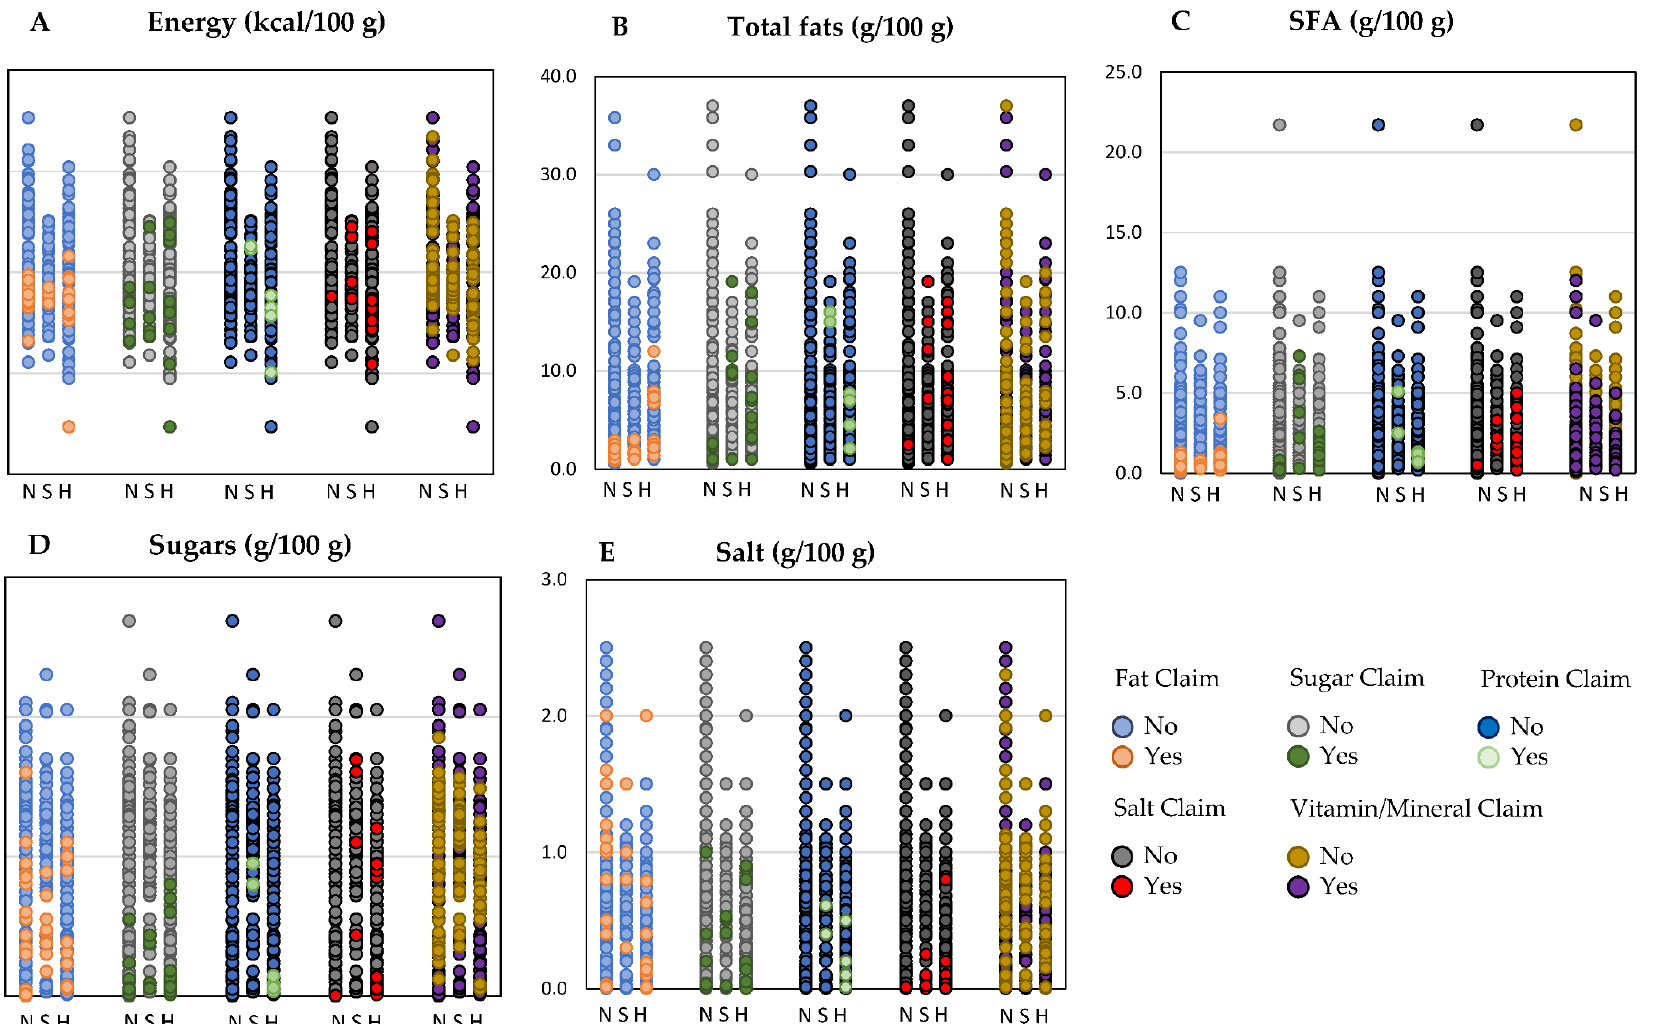
Figure 1. Energy ( A ); nutrients ( B – D ) and salt ( E ) of the considered breakfast cereal products, carrying or not fibre-related and other nutrition claims. Legend: N, no fibre-claim; S, source of fibre; H, high in fibre; SFA, saturates.